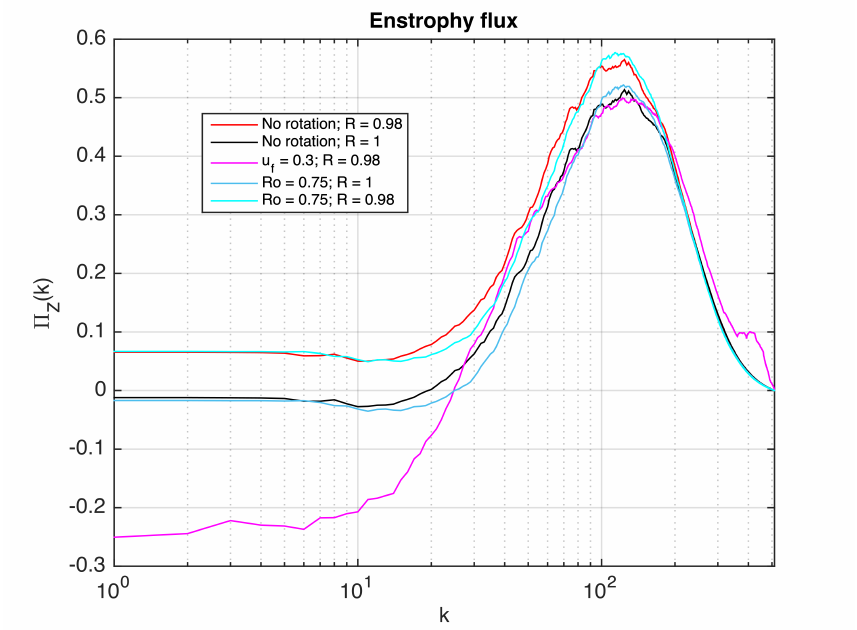
Figure 17. Tukey windowed enstrophy fluxes for strong rotations. Method 1 Ro = 0.75. Method 2 U f = 0.3 with radius of the window R = 0.98